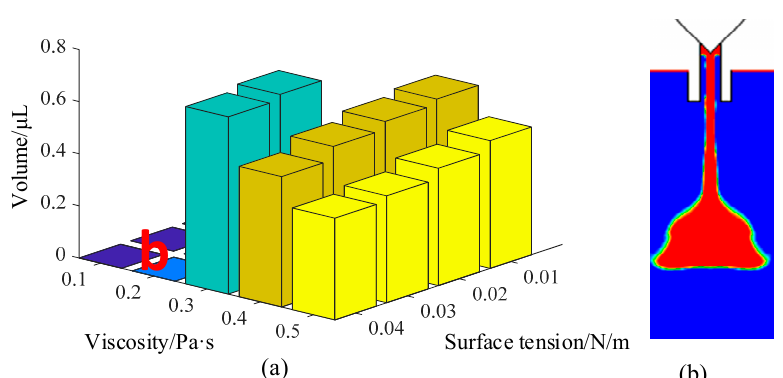
Figure 10. The influence of surface tension and viscosity on the volume of the droplet: ( a ) Jetting volume; ( b ) sputtering. Conditions: The nozzle diameter is 0.2 mm, the frequency is 20 Hz, and the needle displacement is 0.3 mm.